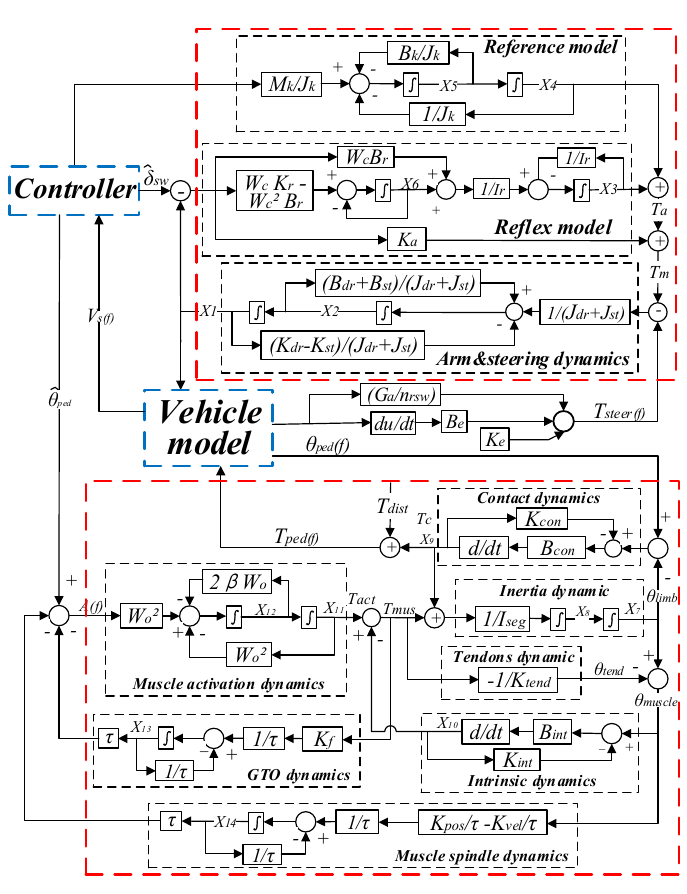
Figure 3. Block diagram of HVSC model.